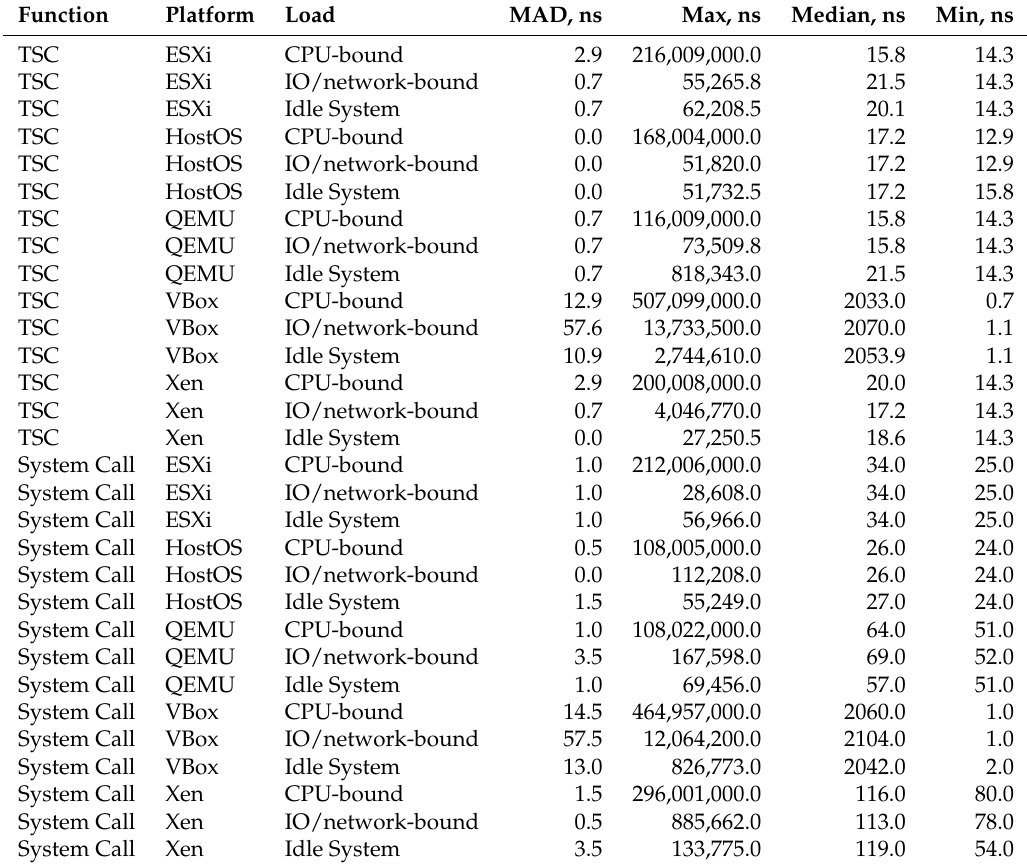
Table 1. Results for all experiments with timing